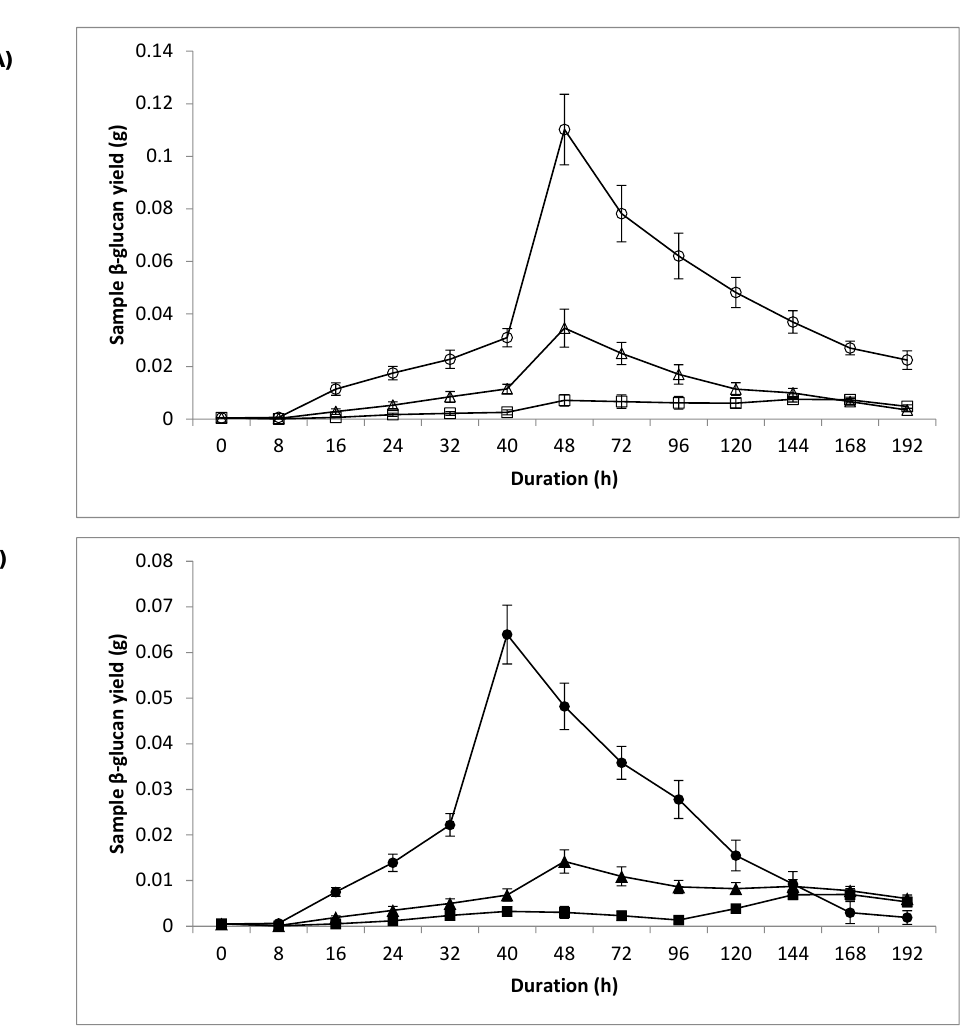
Figure 5. ( A ) β - Glucan yield (%) of a 50-mL sample of non-NaCl-stressed cells during various fermentation times (h) with three different media containing 200, 300, or 400 g/L glucose ( n = 3 replications for each time and error bars represent standard deviation of the average value of all replications with each range of fermentation time). Mean values between 0–144 h were significantly different at p ≤ 0.05 level. ( B ) β -Glucan yield (%) of a 50-mL sample of non-NaCl-stressed cells during various fermentation times (h) with three different media containing 200, 300, or 400 g/L glucose ( n = 3 replications for each time and error bars represent standard deviation of the average value of all replications with each range of fermentation time). Mean values between 0–144 h were significantly different at p ≤ 0.05 level.